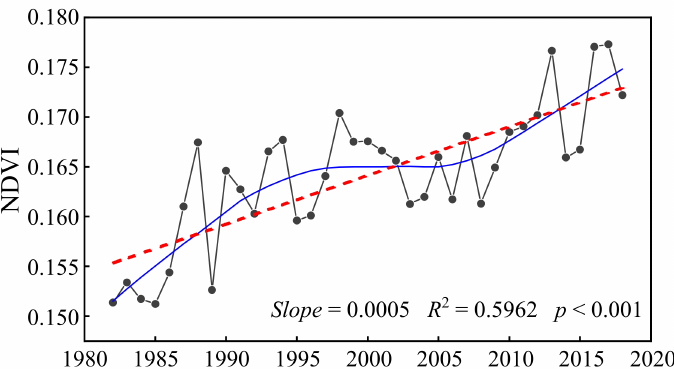
Figure 4. Interannual change of NDVI during the growing season in Xinjiang from 1982 to 2018. The linear trend (red dashed line) is based on Sen’s trend estimation, and the nonlinear trend (blue solid line) is fitted with LOWESS. In the calculation of LOWESS, the smoother span is set as